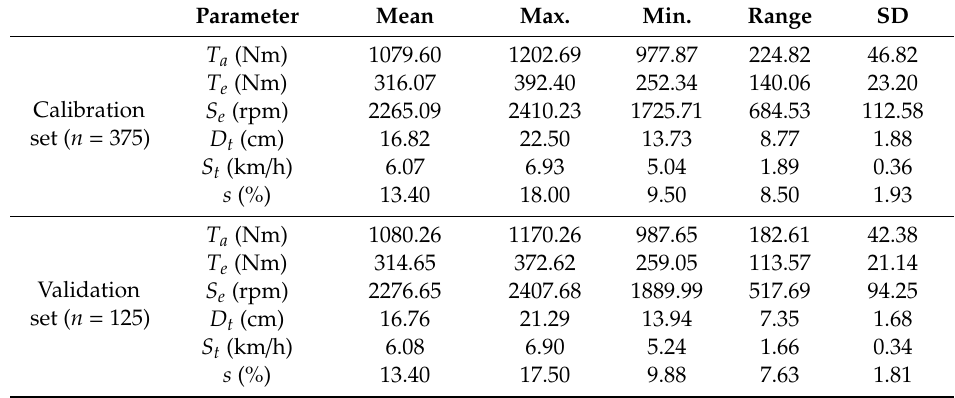
Table 4. Statistical description of the calibration and validation dataset for each variable used in this study.